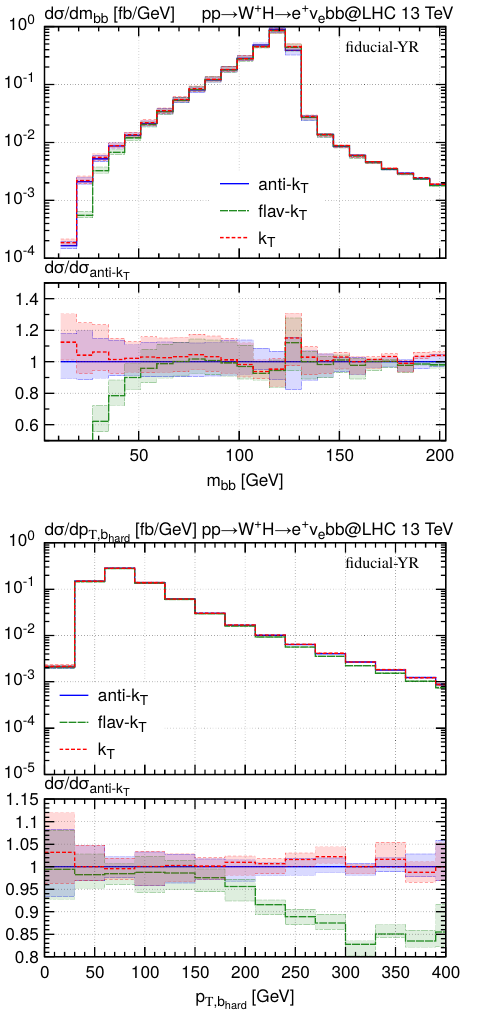
Figure 6 . Differential distributions for e + ν e b ¯ b production with fiducial-YR cuts using different jet-clustering algorithms, all with R = 0 . 4